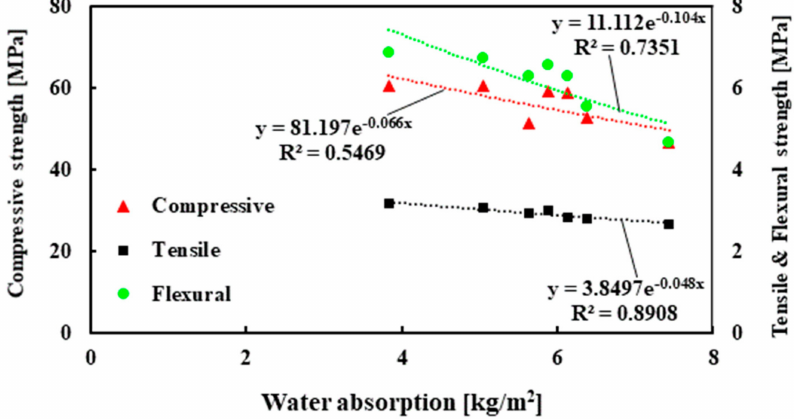
Figure 11. The relation of the water absorption with compressive, tensile, and flexural strength of the